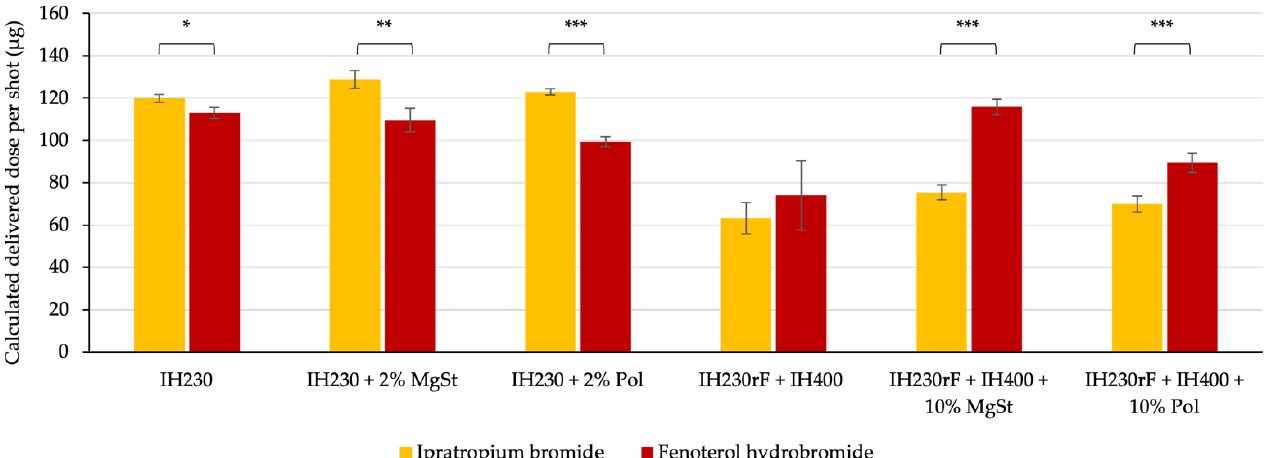
Figure 7. Calculated delivered doses of all assessed formulations in µg. n = 3, error bars denote standard deviation. Significance depicted as: * p -value < 0.05; ** p -value < 0.01; *** p -value < 0.005.